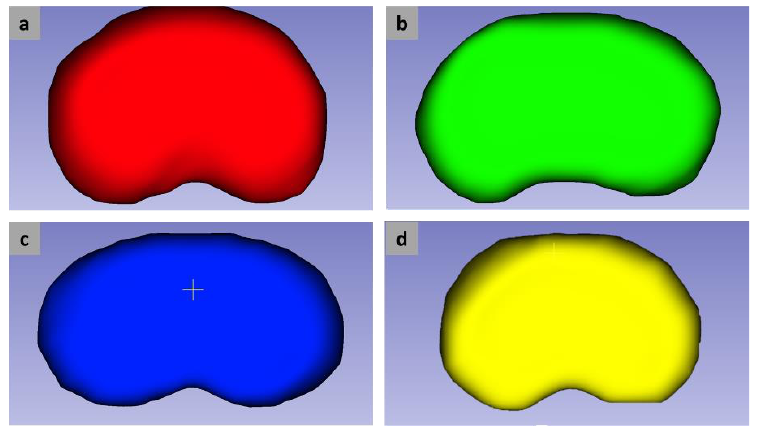
Figure 1. Segmentation results for IVDs in the L1L2 ( a ), L2L3 ( b ), L3L4 ( c ), and L4L5 ( d ) regions.